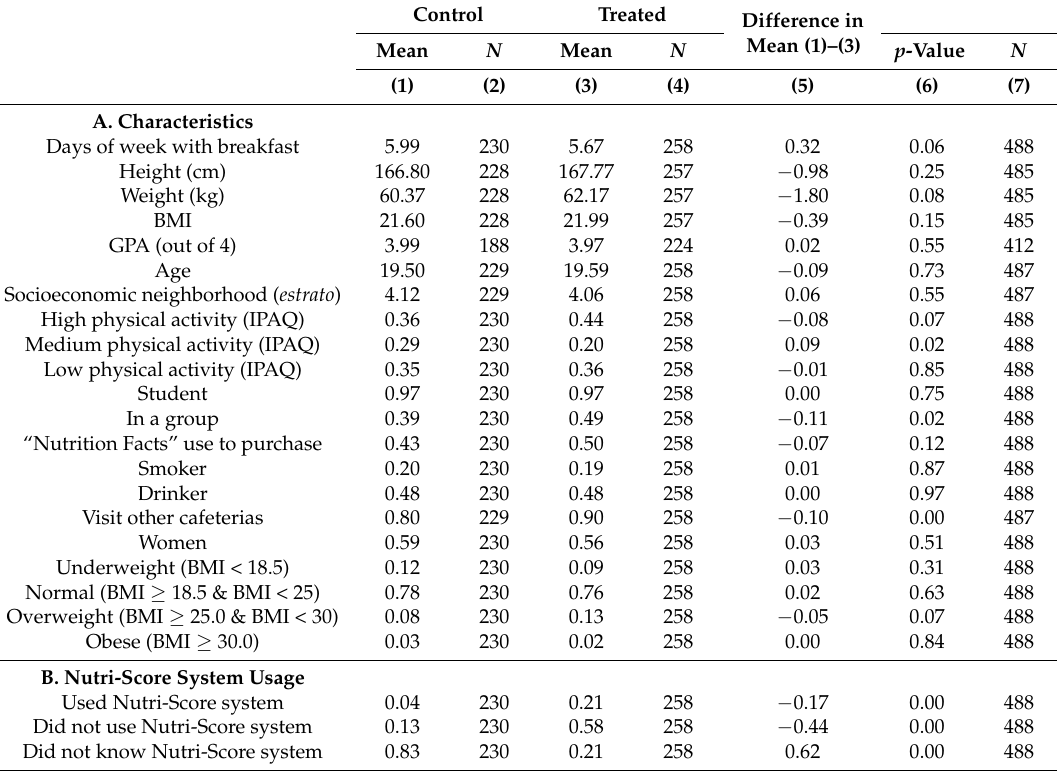
Table 1. Balanced characteristics between control and treated